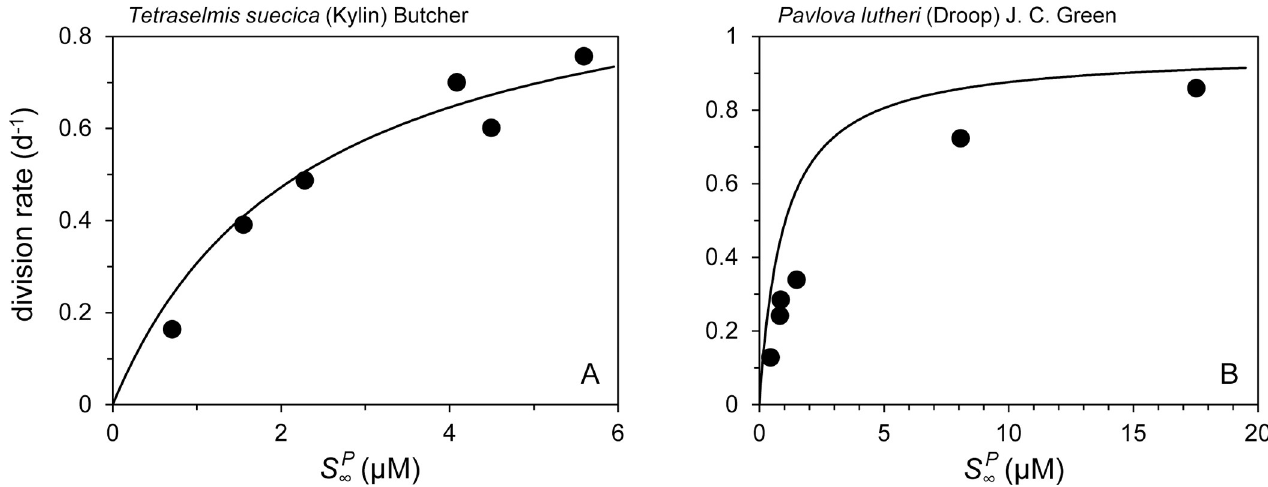
Fig 4. Comparison of model-predicted phytoplankton division rates with measure steady-state rates in PO 4 -limited chemostat cultures. (A) Circles = cell division rates observed by Laws et al. [32] for Tetraselmis suecica (Kylin) Butcher. Solid line = predicted division rates assuming an average cell size of 12 μ m and a maximum division rate ( μ ) of 1.19 d -1 [32]. (B) Circles = cell division rates observed by Laws et al. [55] for Pavlova lutheri (Droop) Green. Solid m line = predicted division rates assuming an average cell size of 6 μ m and a μ m of 0.98 d -1 [55].